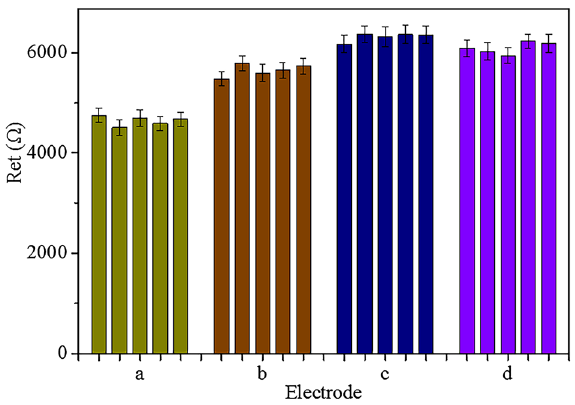
Figure 7. Reproducibility of the four immunosensors in the presence of 10 3.82 EID 50 mL −1 ARV (a) GE-G-